Question: Give a one-sentence summary of this figure.
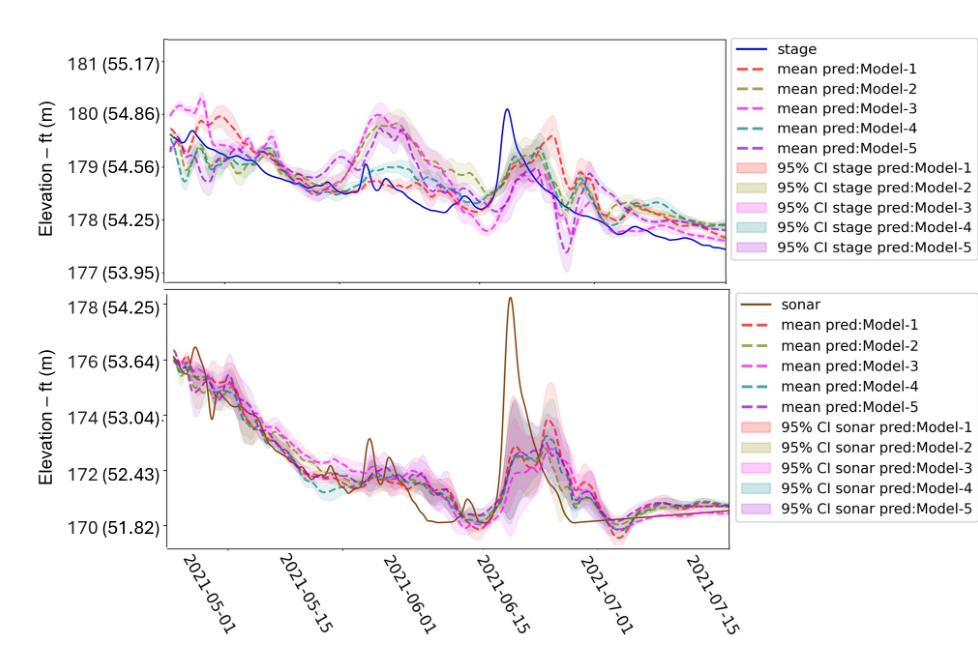
Answer: Stage (top) and Sonar (bottom) predictions of top-5 FCN models. The mean and 95% confidence intervals are considered on the test dataset - Oregon Luckiamute bridge.